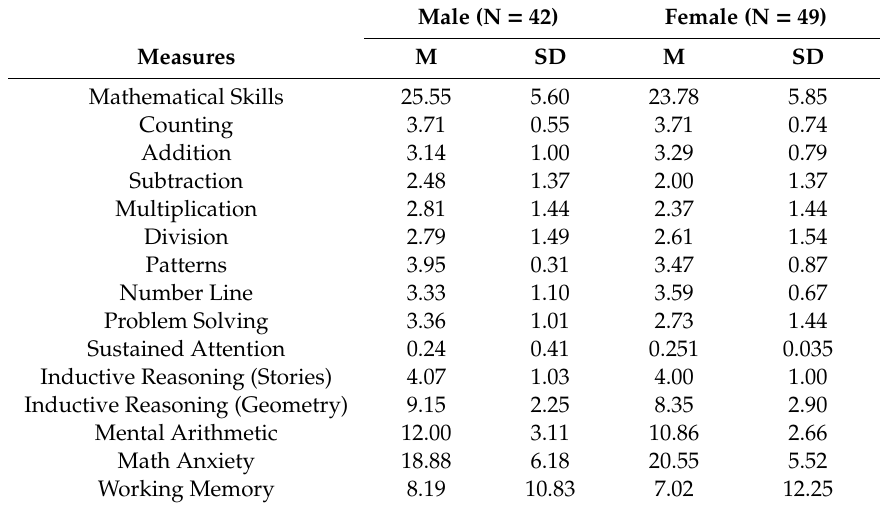
Table 4. Descriptive statistics for mathematical measures and cognitive skills in terms of